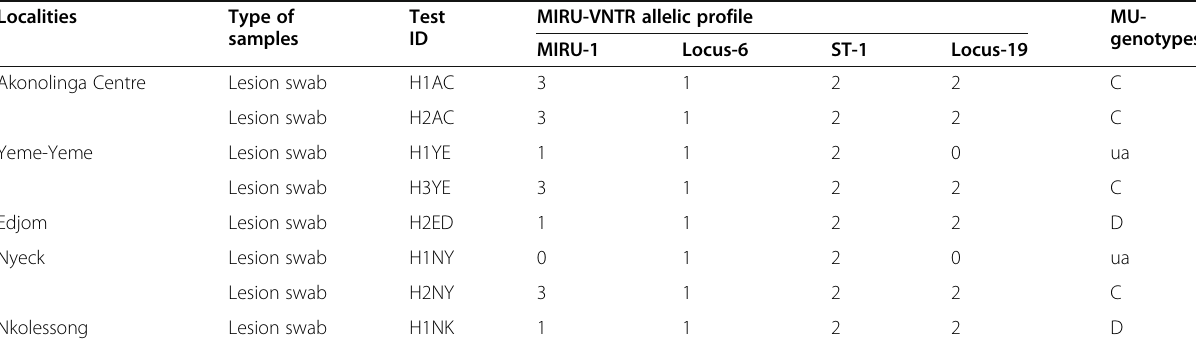
Table 3 VNTR profile of MU isolates detected in human lesions Localities Type of